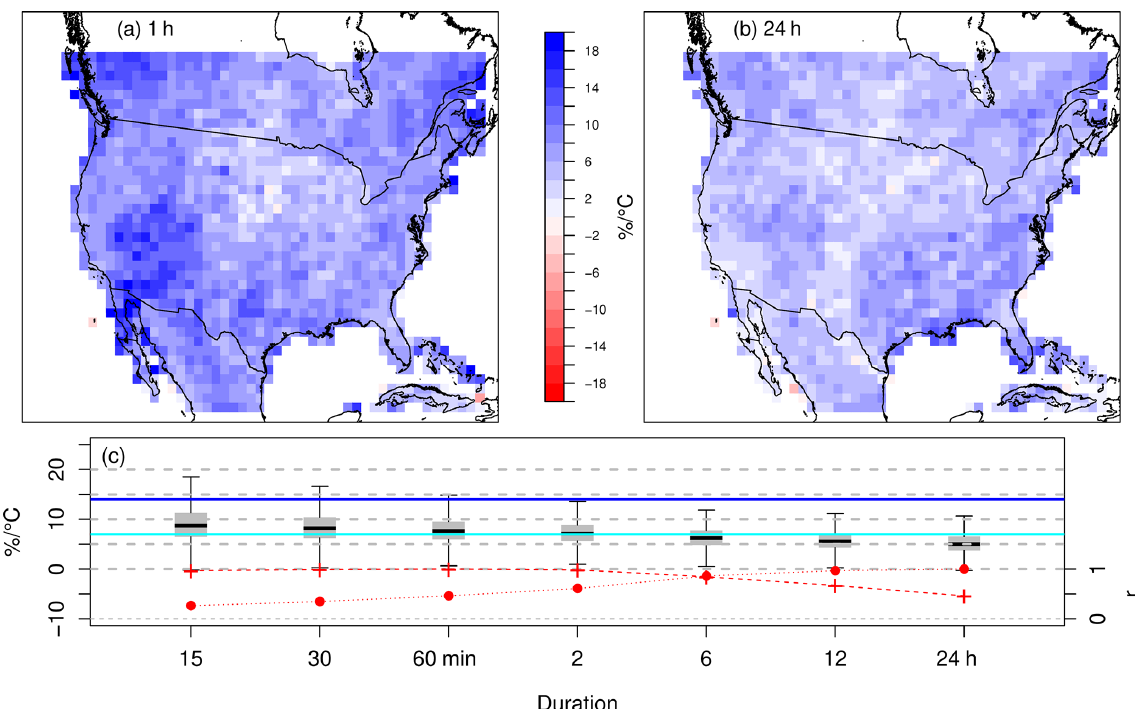
Figure 10. Temperature scaling of 10-year return levels of (a) 1h and (b) 24h extreme rainfall; values shown are aggregated 100km × 100km grid box means. (c) Box plots summarizing the distribution of temperature scaling values for 10-year return levels of 15min to 24h duration extreme rainfall. The horizontal line in the middle of each box indicates the median, boxes extend from the lower quartile to the upper quartile, and the whiskers extend to 1.5 times the IQR. The horizontal cyan (blue) line indicates temperature scaling of 7% ◦ C − 1 (14% ◦ C − 1 ). The red dashed (dotted) lines and the secondary vertical axis indicate the spatial correlation between maps of temperature scaling for each duration and the 1h (24h)